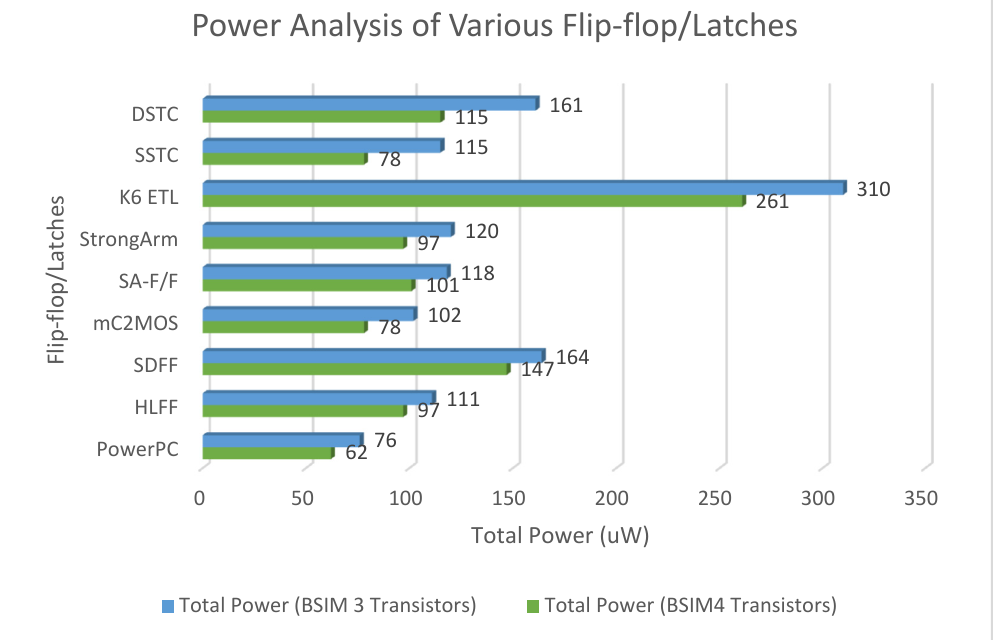
Figure 20. Power Analysis of various flip-flop/latch topologies using 65 and 130 nm process technologies. Transistor model quality and input signal selection play an important role in the accurate estimation of harmonic contents of switching waveforms. We used a square- shaped signal as an input to our simulations (neither a sinusoid nor a perfect square wave). A perfect square wave causes discontinuity in the spectrum due to abrupt change, and a sinusoid-shaped wave has slower edges, which produce extra short-circuit power.